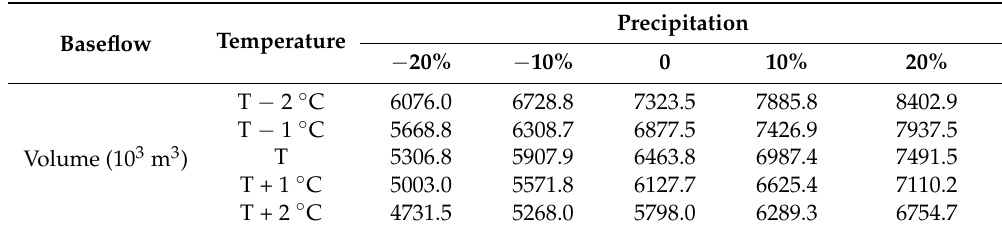
Table 5. Annual baseflow simulated in different scenarios.